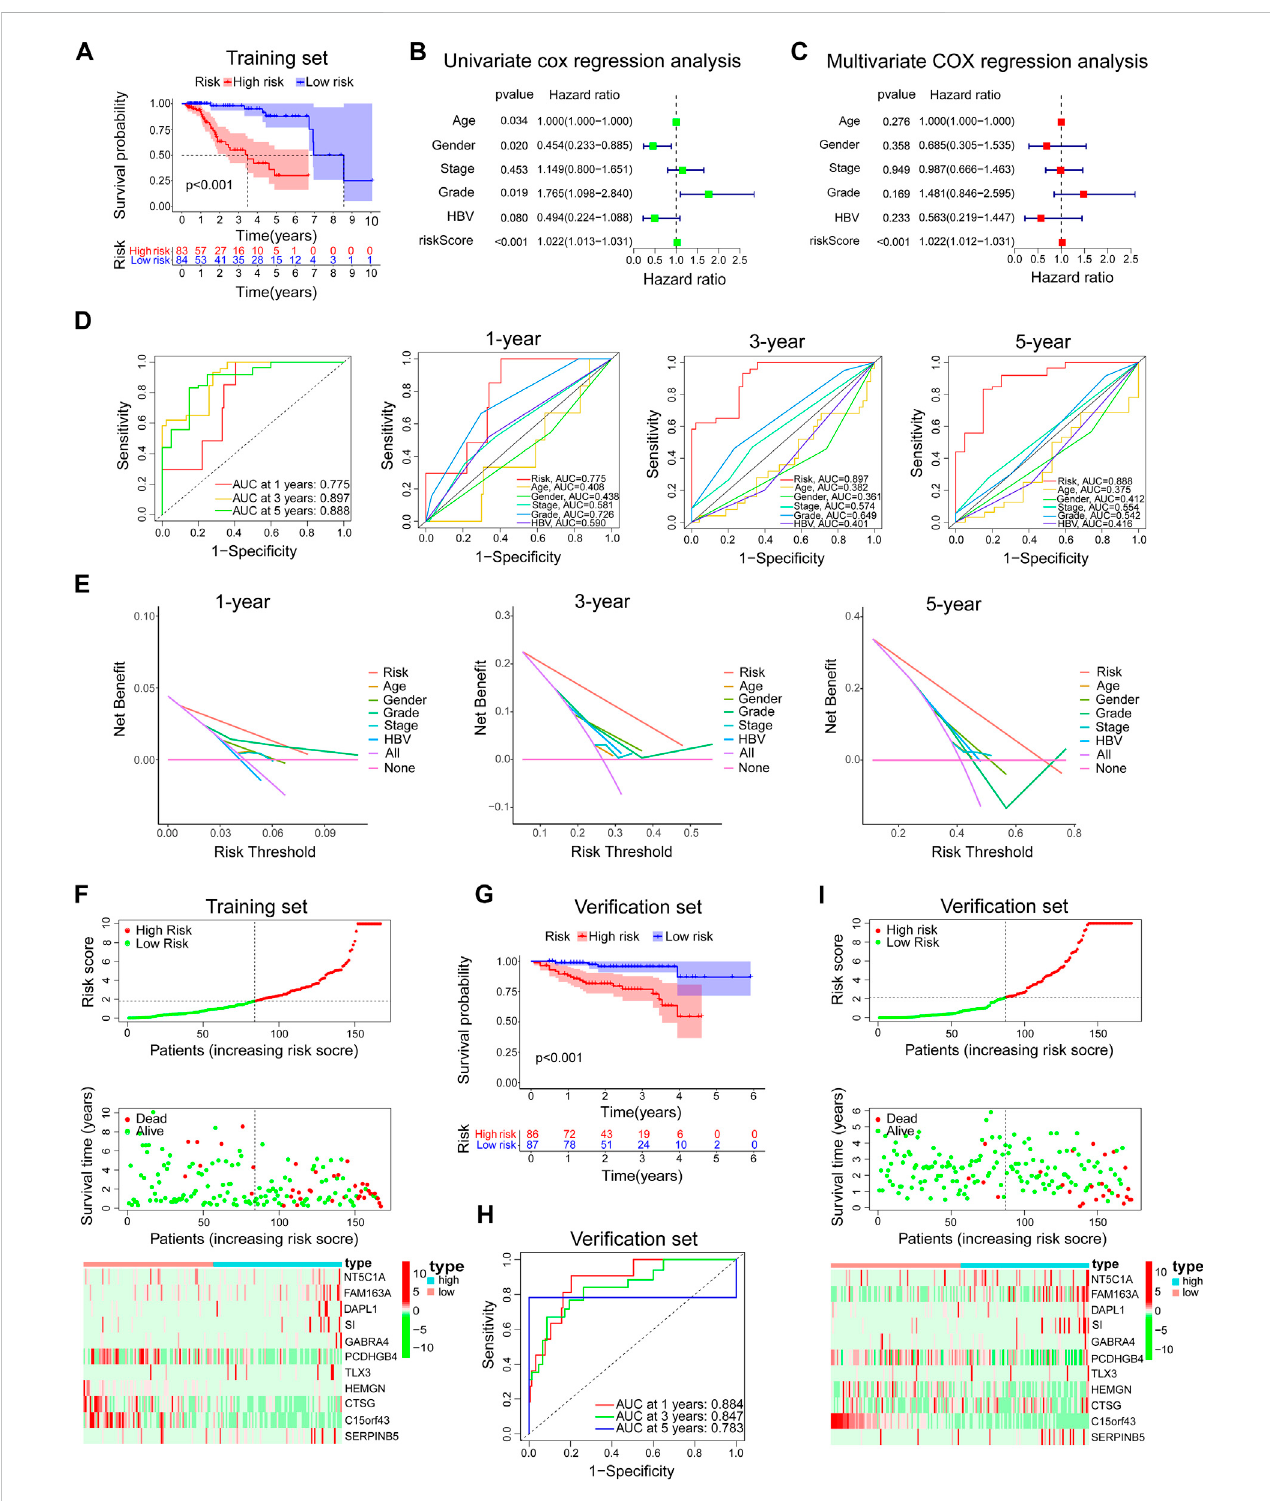
FIGURE 5 Evaluation and veri fi cation of the prediction ability of the model. In the training set, (A) Kaplan-Meier survival analysis between the high-risk group and low-risk group. (B,C) Univariate andmultivariateCOXregressionanalysis ofprognosticriskmodelandclinicalfeatureswithOS. (D) Thetime-dependentROC curveoftheprognosticriskmodelandthecomparisonwiththepredictiveabilityofmajorclinicalfeatures. (E) TheDCAcurveoftheprognosticriskmodeland the comparison with the predictive ability of major clinical features. (F) Risk factor linkage analysis: the distribution and median of the model risk score, thedistributionofdeadpatientsinthehighandlow-risk group,andtheexpressionofgenesinvolvedintheconstructionofthemodelinthehighandlow-risk group. In the veri fi cation set, (G – I) The predictive ability of the prognostic risk model was further veri fi ed by Kaplan-Meier survival analysis, ROC analysis, and risk factor linkage